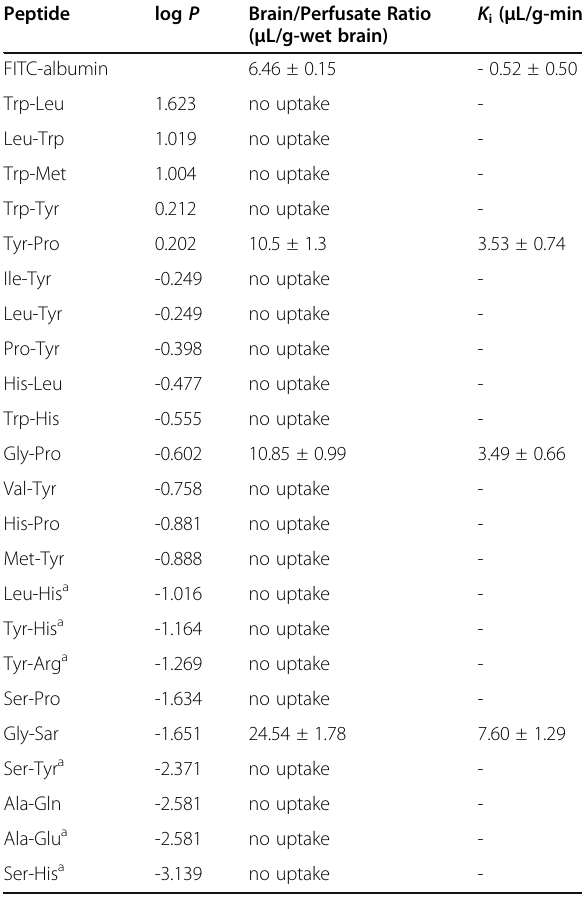
Table 2 Brain/perfusion ratio of dipeptides in mouse perfusion experiments